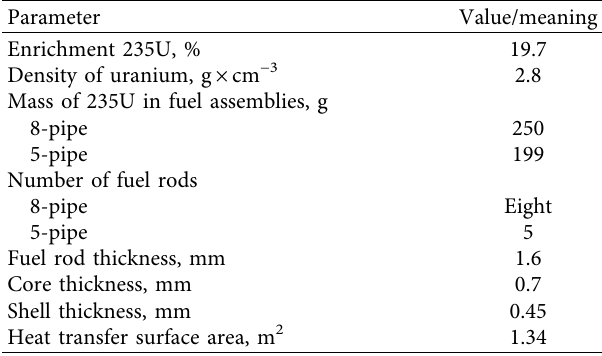
Table 2: Characteristics of fuel assemblies VVR-KN [5].